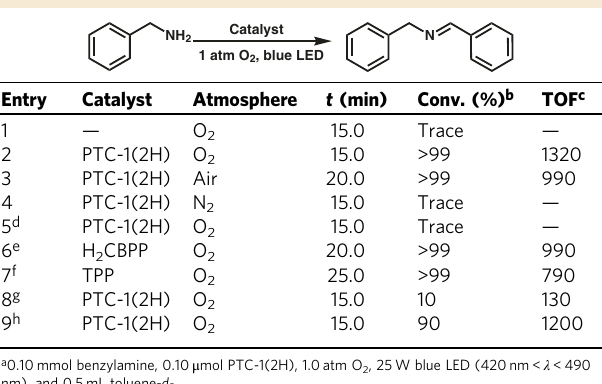
Table 2 Homogeneous visible light oxidative coupling of various amines into imines a